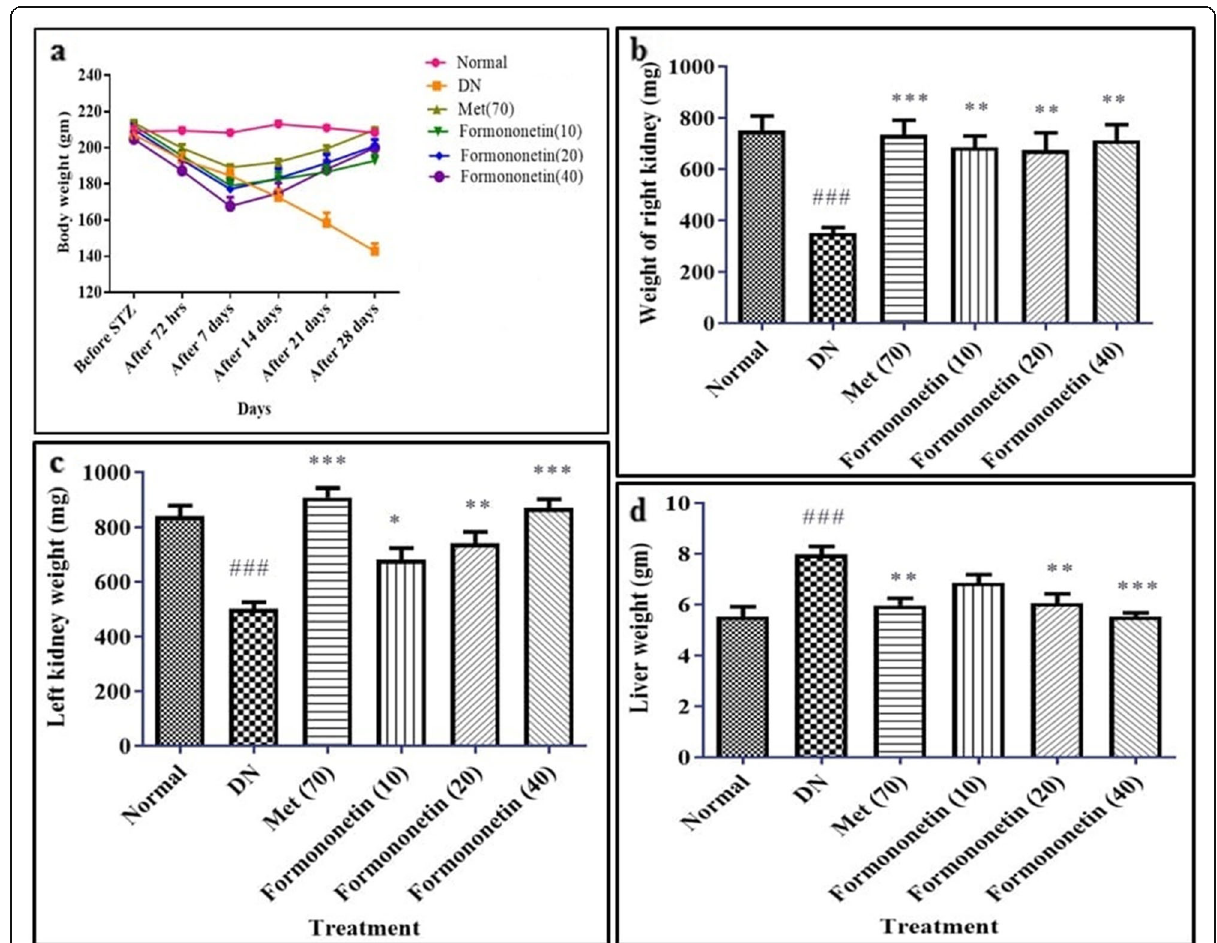
Fig. 1 Effect of formononetin on change in body and organ weight. Data were presented as mean ± S.E.M. (n-6). The result values were statistically analyzed by using one-way ANOVA and two-way ANOVA followed by Bonferroni ’ s test for multiple